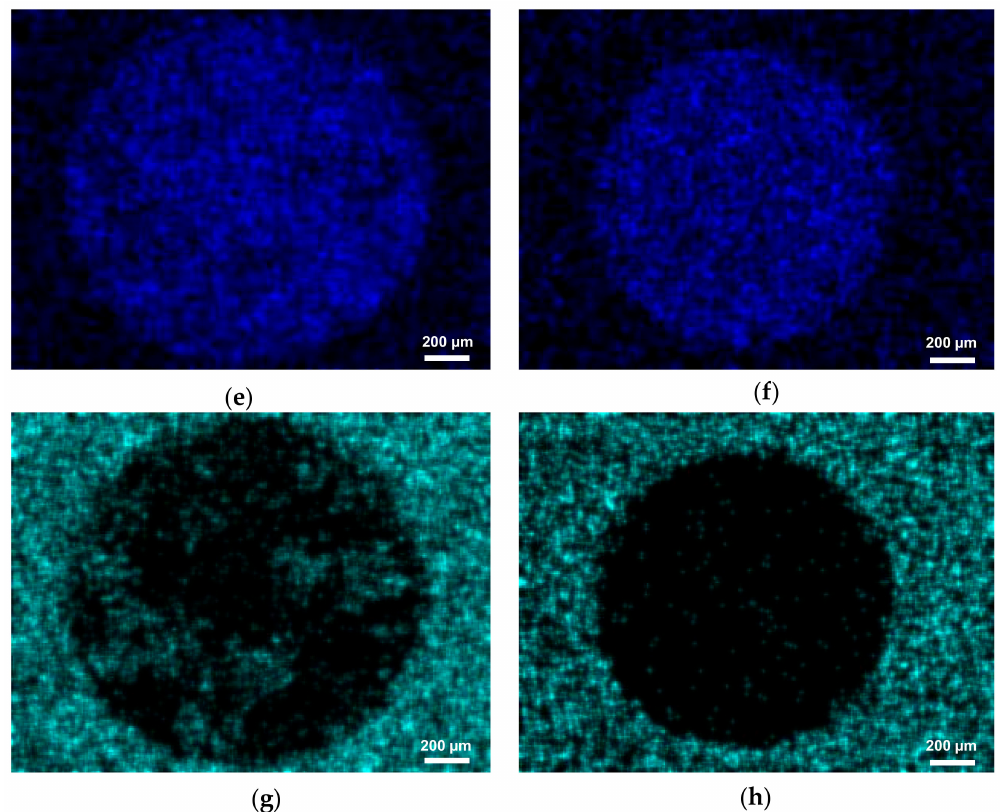
Figure 7. SEM images of the fretting wear scar formed on the surface of the as-received ( a ) and UNSM-treated ( b ) specimens. The composition mapping image of the fretting wear scar on the surface of the as-received ( c ) and UNSM-treated ( d ) specimens. Distribution of Fe ( e , f ), and Ni ( g , h ) over the fretting wear scar formed on the surface of the as-received ( a ) and UNSM-treated ( b ) specimens,